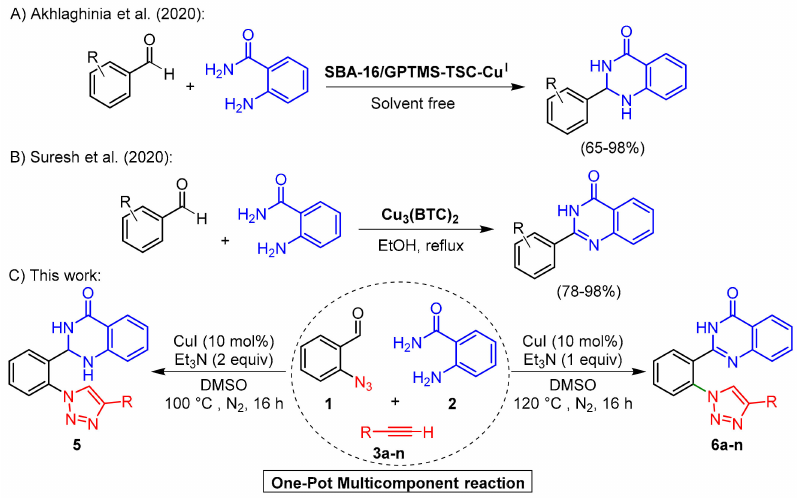
Figure 2. Recent examples of the copper-catalyzed synthesis of quinazolinones and this